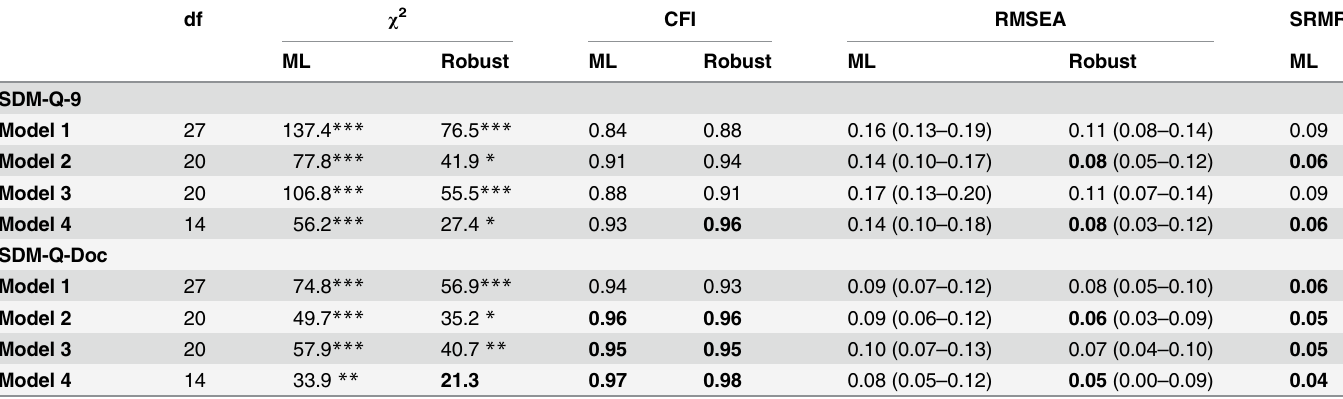
Table 7. Results of the Confirmatory Factor Analysis (CFA) for the SDM-Q-9 and SDM-Q-Doc: Maximum Likelihood (ML) and Robust statistics.